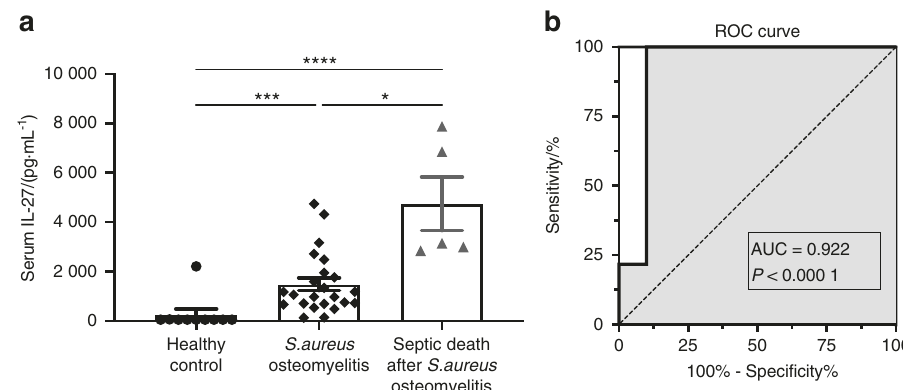
Fig. 1 Serum IL-27 levels are elevated in patients with S. aureus infection. a Serum samples were collected from healthy individuals ( n = 10), orthopedic patients with culture-con fi rmed S. aureus bone infections ( n = 23), and patients who died from septic S. aureus osteomyelitis ( n = 5). Serum IL-27 levels were determined via a Luminex assay. The data for each sample are presented as the mean ± SEM for each experimental group. b The Luminex data were utilized to generate a receiver operating characteristic (ROC) curve, and the areas under the curve (AUC) for the controls and infected patients are presented. Note that the serum IL-27 level is highly predictive of S. aureus osteomyelitis. The dashed line represents a nondiscriminatory test with equal sensitivity and speci fi city (* P < 0.05, *** P < 0.001, **** P < 0.000